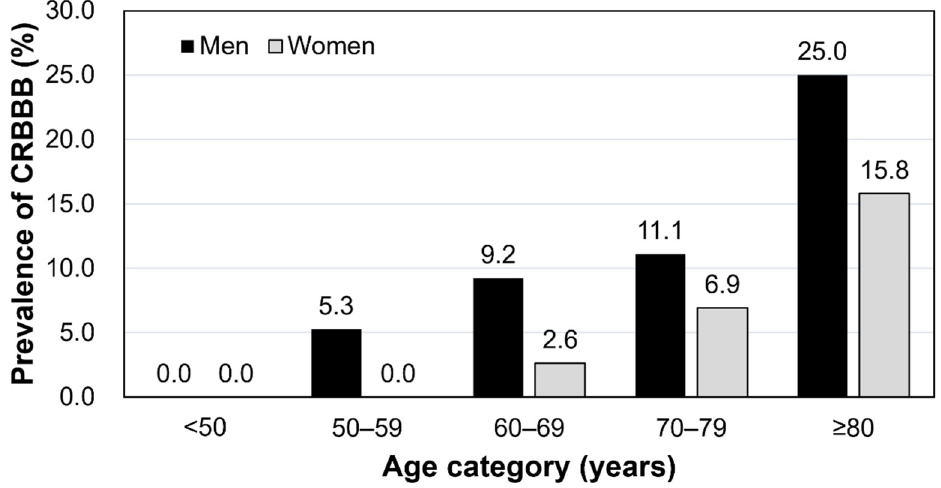
Figure 1. Prevalence of CRBBB by sex and age category. The bar graph shows prevalence (percent- age) of CRBBB by age and sex. Abbreviation: CRBBB, complete right bundle branch block.